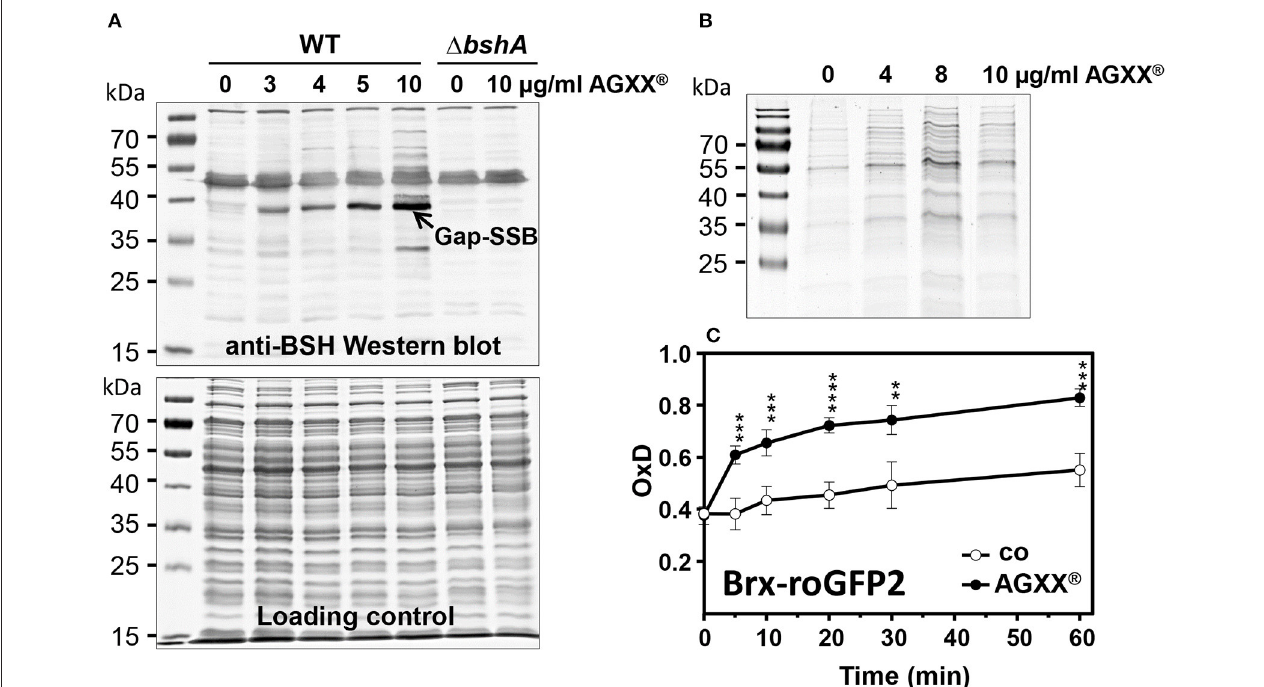
FIGURE 4 | AGXX ® causes protein S -bacillithiolation, protein aggregation and an oxidative shift in the BSH redox potential in S. aureus . (A) Non-reducing BSH-specific Western blot analysis showed increasing of S -bacillithiolated GapDH protein in S. aureus USA300 strain under AGXX ® stress. The Coomassie-stained SDS-PAGE is shown as loading control below the BSH Western blot. (B) To analyze protein aggregates, S. aureus cells were grown in RPMI medium to OD 500 of 0.5 and treated with 4–10 µ g/ml AGXX ® for 30min. The insoluble protein fractions of protein aggregates were obtained by centrifugation of the cell lysates and repeated centrifugation of the NP-40-dissolved pellet as described in the Methods section. The insoluble protein fractions were analyzed by SDS-PAGE and visualized with Coomassie staining (C) S. aureus COL expressing Brx-roGFP2 was treated with the sub-lethal amount of 4 µ g/ml AGXX ® at OD 500 of 0.5 in RPMI medium and the biosensor oxidation degree (OxD) was measured at different times after stress. The Brx-roGFP2 biosensor is rapidly oxidized by AGXX ® . The OxD values of the Brx-roGFP2 biosensor measurements with and without AGXX ® were calibrated to fully reduced (DTT-treated) and oxidized (diamide-treated) control samples. The OxD values of fully reduced and oxidized controls were defined as “0” and “1,” respectively. The data were calculated as mean values from 3 biological replicate experiments. Error bars represent the SD and p -values are calculated using a Student’s unpaired two-tailed t -test by the graph prism software. Symbols are defined as follows: ** p ≤ 0.01; *** p ≤ 0.001 and **** p ≤ 0.0001 ( p < 0.0003 for control/AGXX stress at 5min; p = 0.0002 at 10min; p < 0.0001 at 20min; p = 0.0013 at 30min; p = 0.0001 at